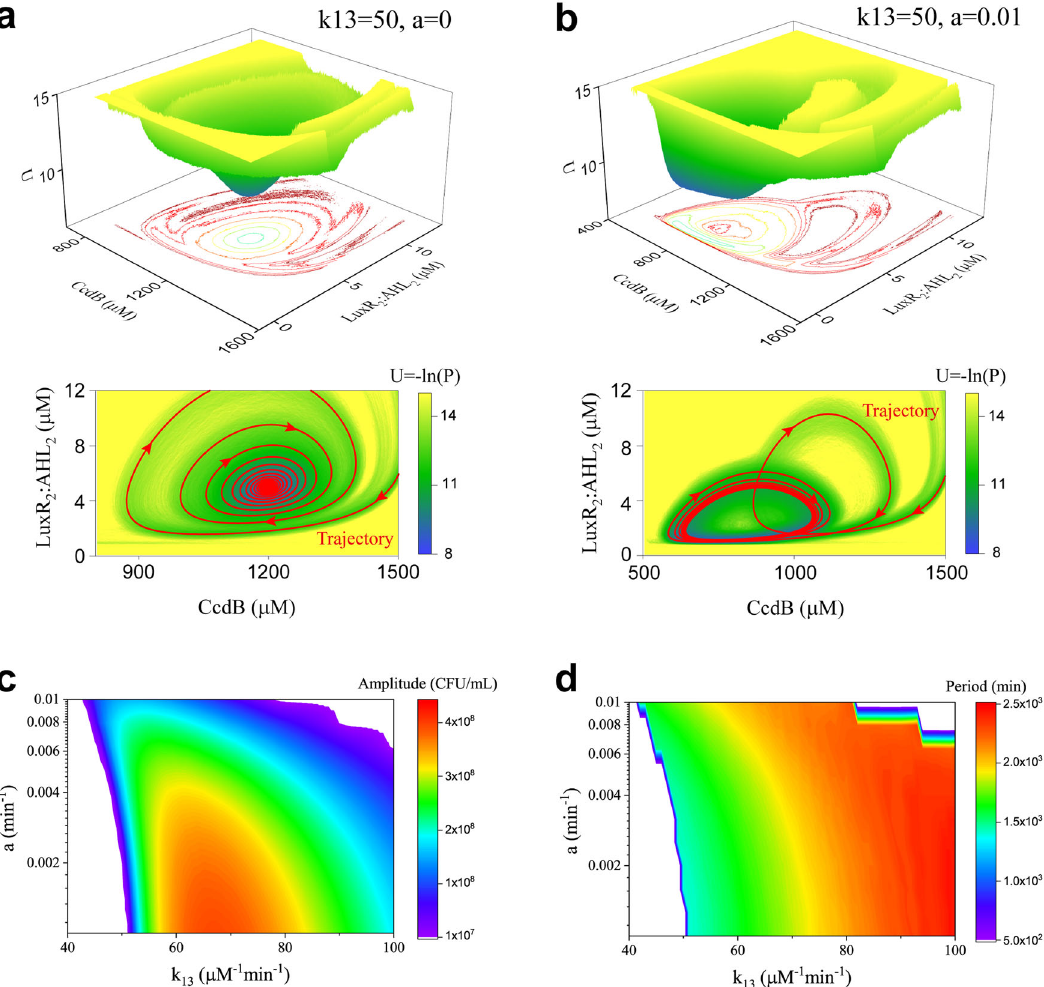
Fig. 8 Dual roles of toxic metabolic factors in controlling oscillation in the quorum sensing system. a , b Addition of the toxic metabolic factors switches the system from the vortex-like pattern landscape to the Mexican hat landscape. c , d Two-parameter bifurcation diagrams of the amplitude and period as a function of k 13 and a . Oscillations occur within the color region and no oscillation occurs in the white region.